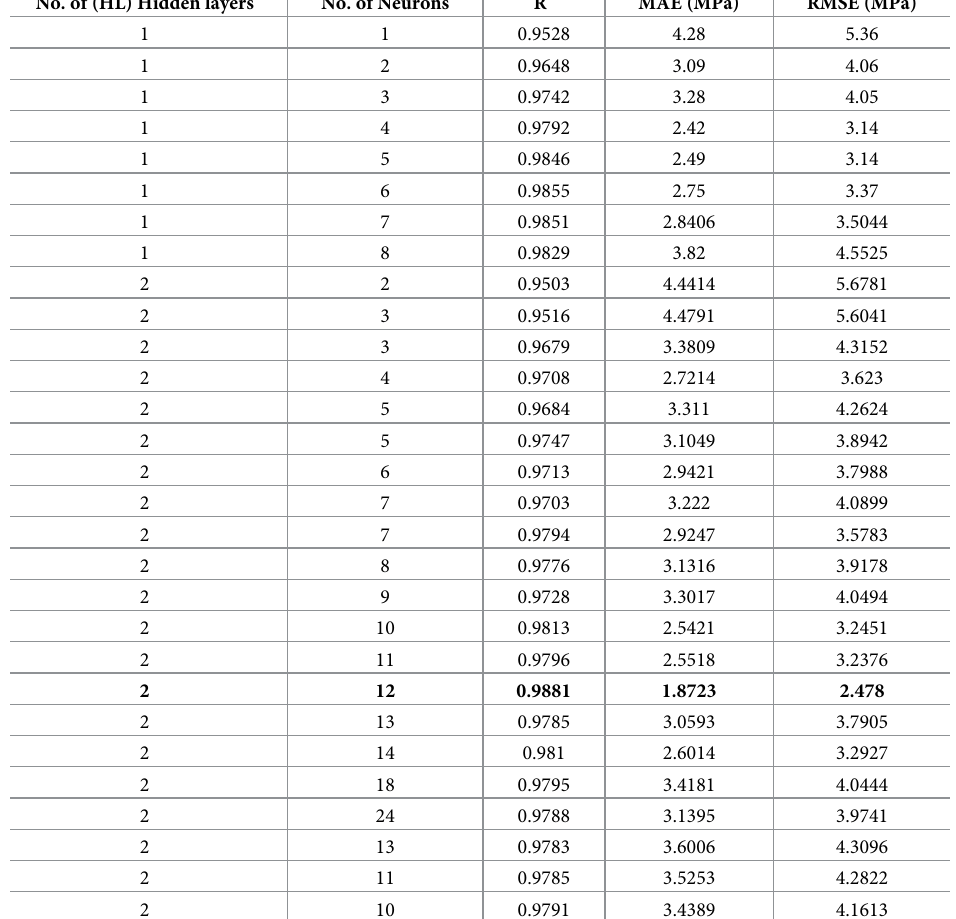
Table 2. The tested ANN